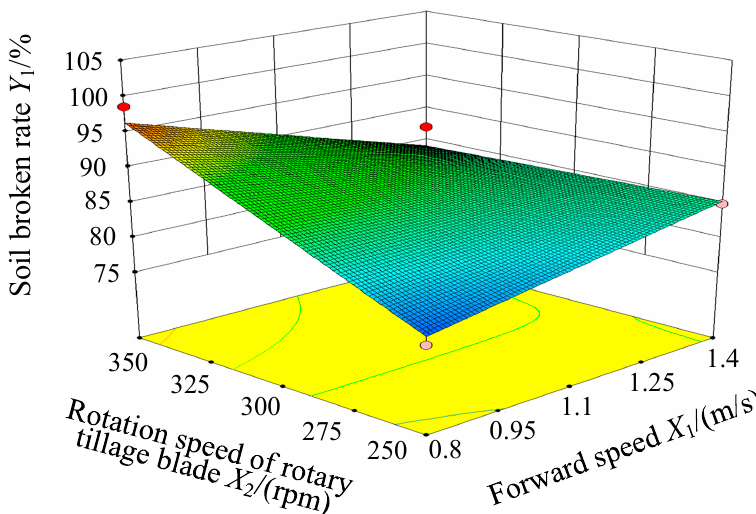
Figure 9. Response surfaces of soil breaking rate to interactive factors X 1 X 2 .